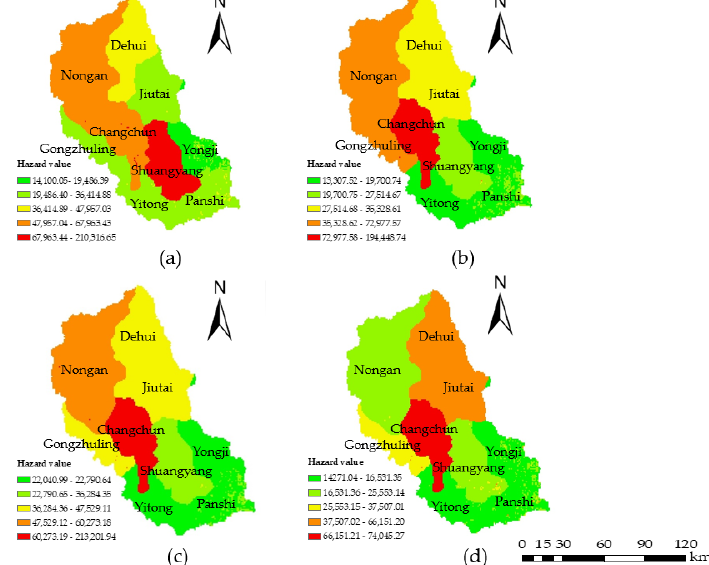
Figure 3. Water environmental hazard maps for ( a ) 2000; ( b ) 2005; ( c ) 2010; and ( d ) 2015. The color scale from green to red represents slightly hazardous, lightly hazardous, moderately hazardous, highly hazardous, and extremely hazardous, respectively.